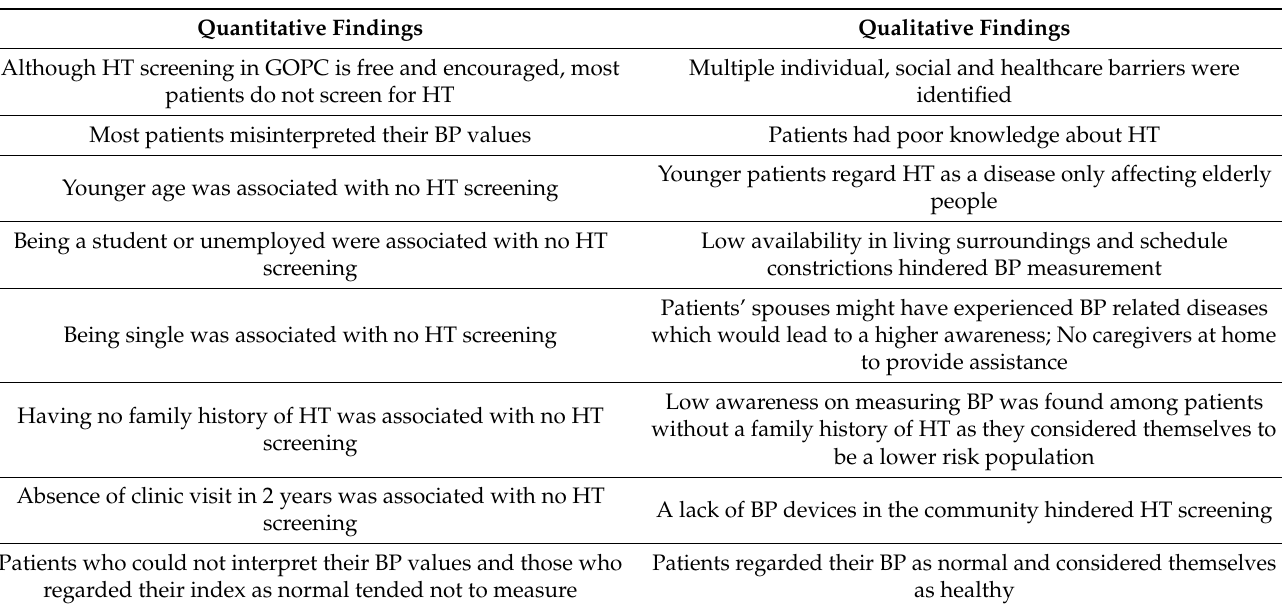
Table 4. Summary of the mixed-method